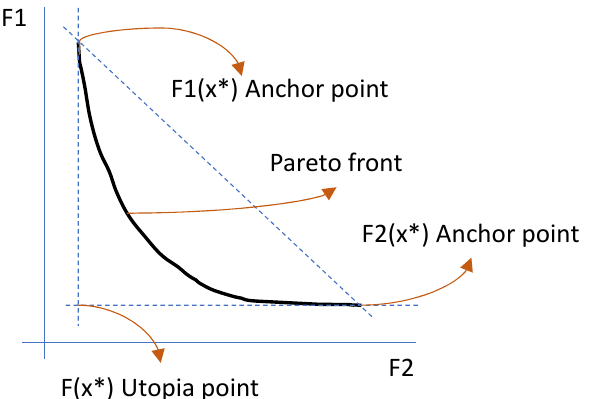
Figure 1. Demonstration of Pareto front for a bi-objective optimization